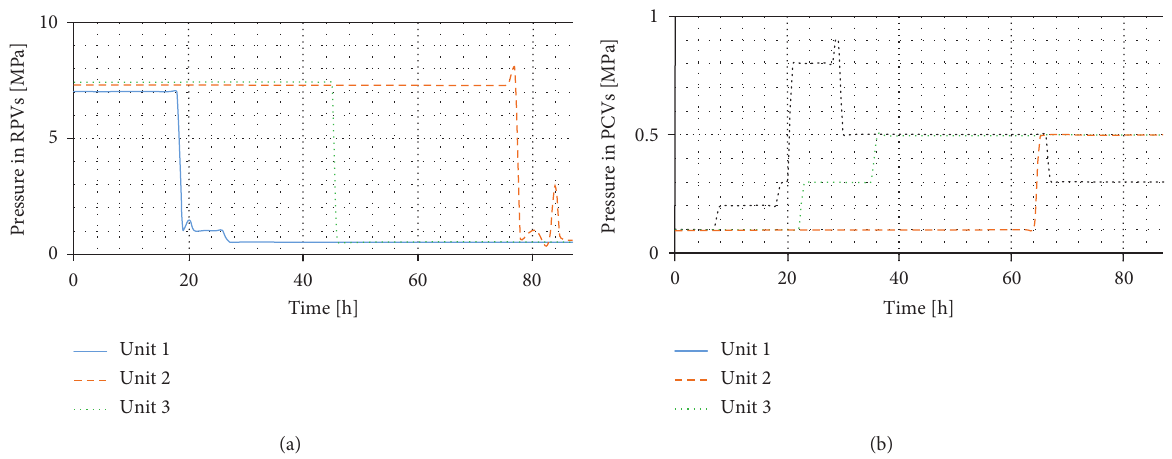
Figure 4: Conditions of the pressures in Units 1–3 for Modified ART Mod 2 code: (a) the RPVs and (b) the PCVs.